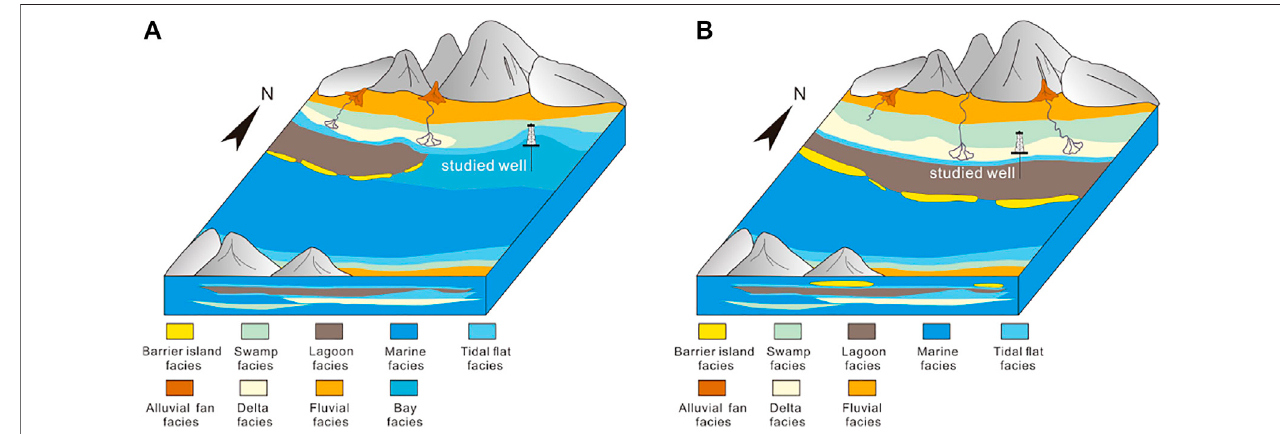
FIGURE 10 | Sedimentary model of transitional shale for Shan 2 3 -1 section (A) and the other three sections (B) (modi fi ed from Zhang et al.,